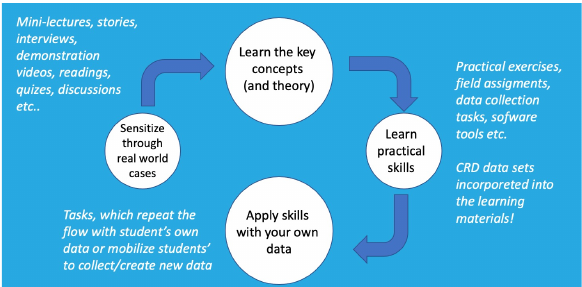
Figure 1. Learning flow of the Resilience Academy online learning courses.